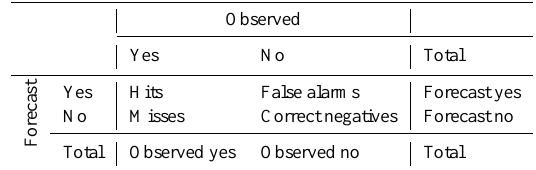
Table A2. Contingency table of a categorical